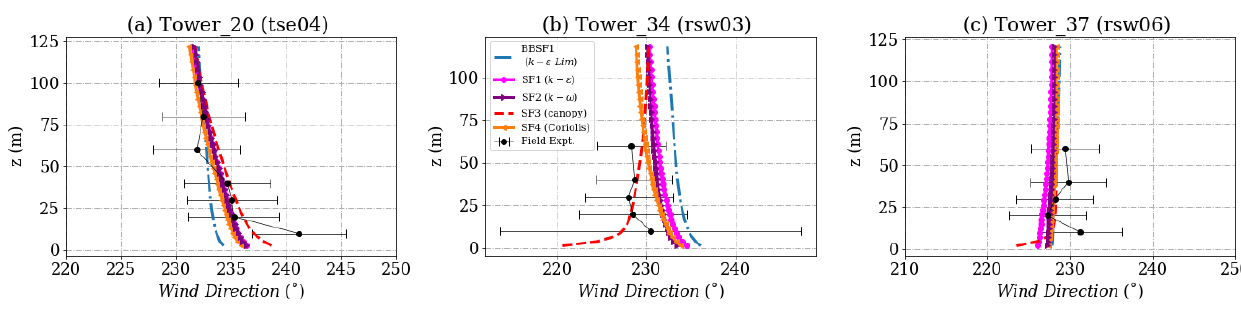
Figure 8. Simulation results and experimental data for wind direction on the southwest ridge for (a) Tower 20 (tse04), (b) Tower 34 (rsw03) and (c) Tower 37 (rsw06). The locations of the masts are given in Fig. 2.